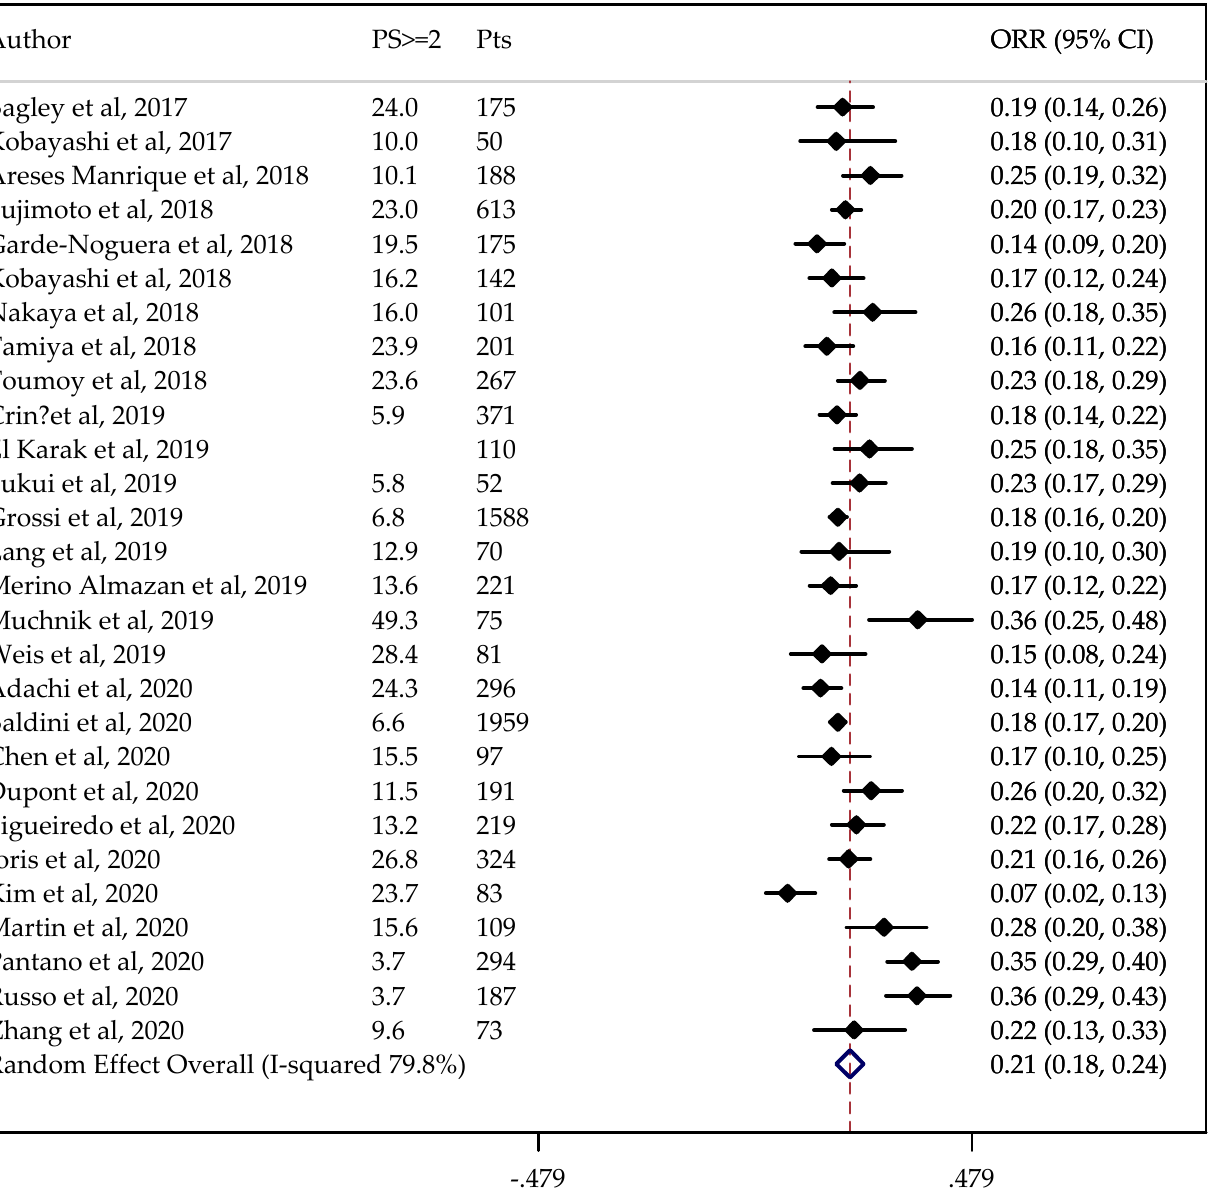
Figure 2. Forest plot of non-small cell lung cancer (NSCLC) objective response rate (ORR) adjusted for performance status (PS). The ORRs were either taken directly from individual studies or calculated using reported numbers of responding and total treated patients. PS ≥ 2: proportion of patients with PS ≥ 2.